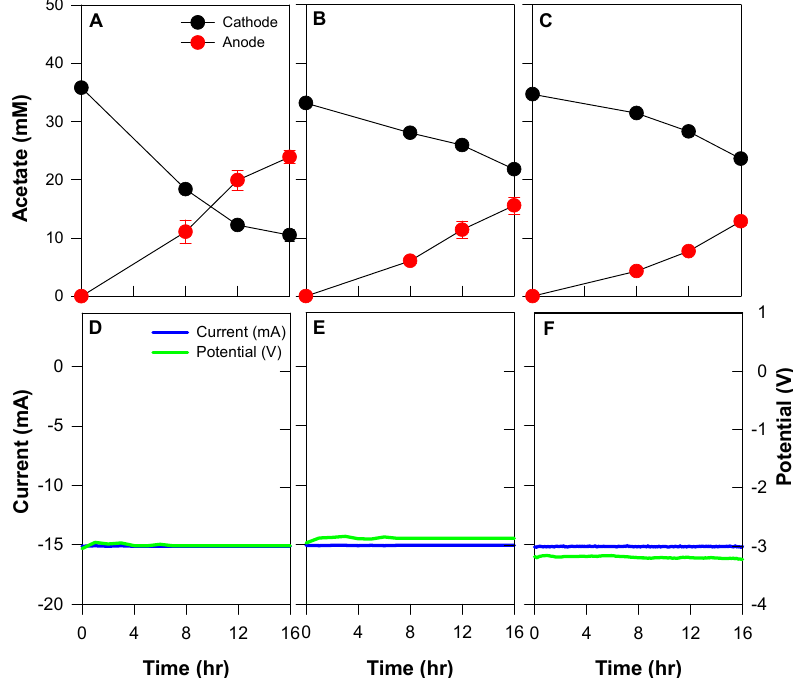
Figure 5. Comparison of acetate transportation in an electrodialysis cell with synthetic media containing acetate ( A , D ), and centrifuged C1 gas fermentation broth ( B , E ) and non-centrifuged C1 gas fermentation broth ( C , F ).